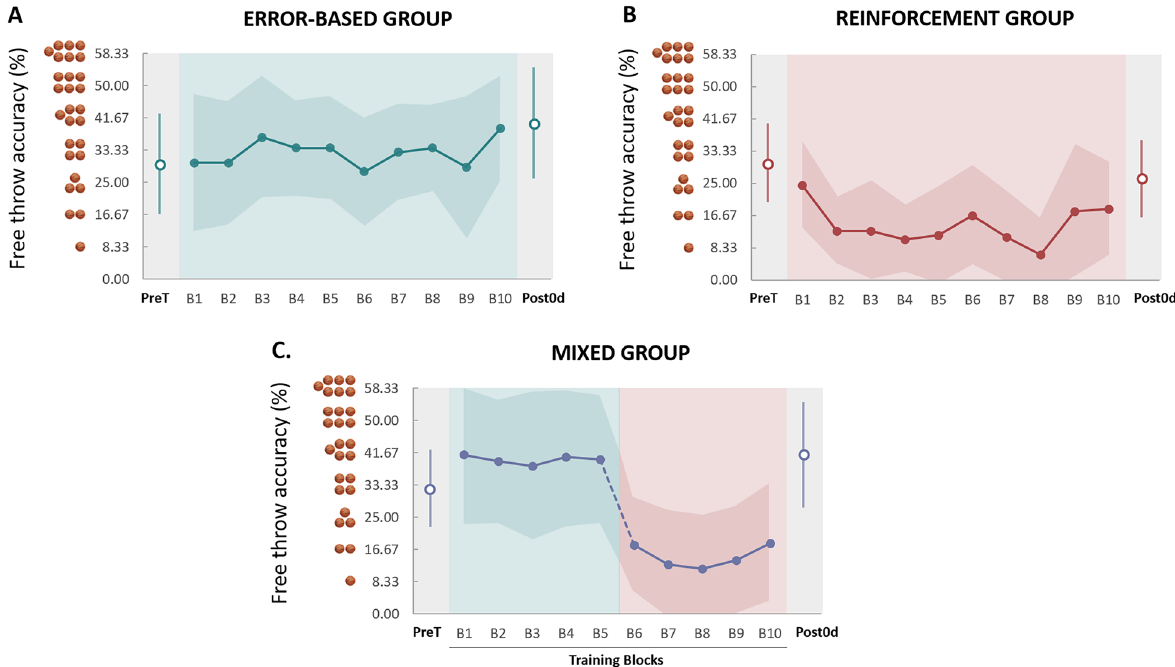
Figure 3. Block-by-block illustration of the free throw accuracy (%) during the training session (closed circles). Each block shows an average (+ SD) of 12 free throws. Open circles depict the free throw accuracy in pre-training (PreT) and post-training (Post0d) sessions. ( A ) Error-Based group. ( B ) Reinforcement group. ( C ) Mixed group. The broken line indicates the transition from error-based training to reinforcement